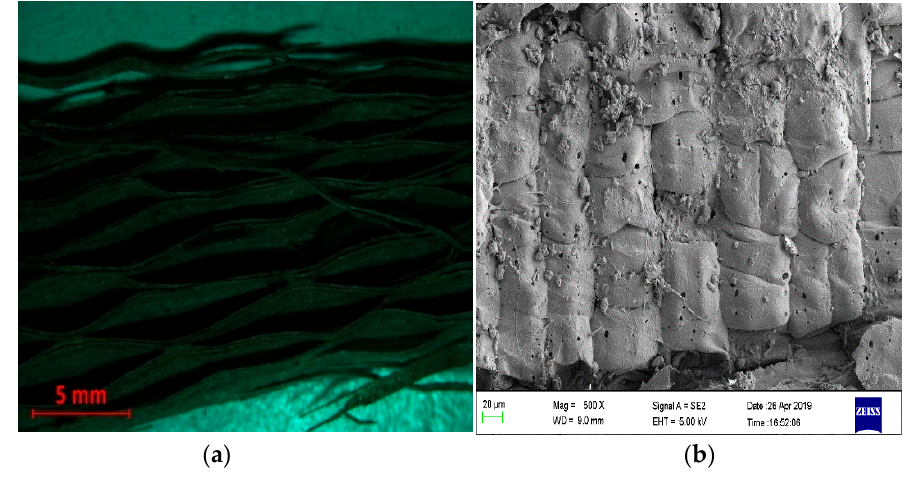
Figure 2. ( a , b ) Optical and SEM representation of untreated network structure pawpaw fiber.